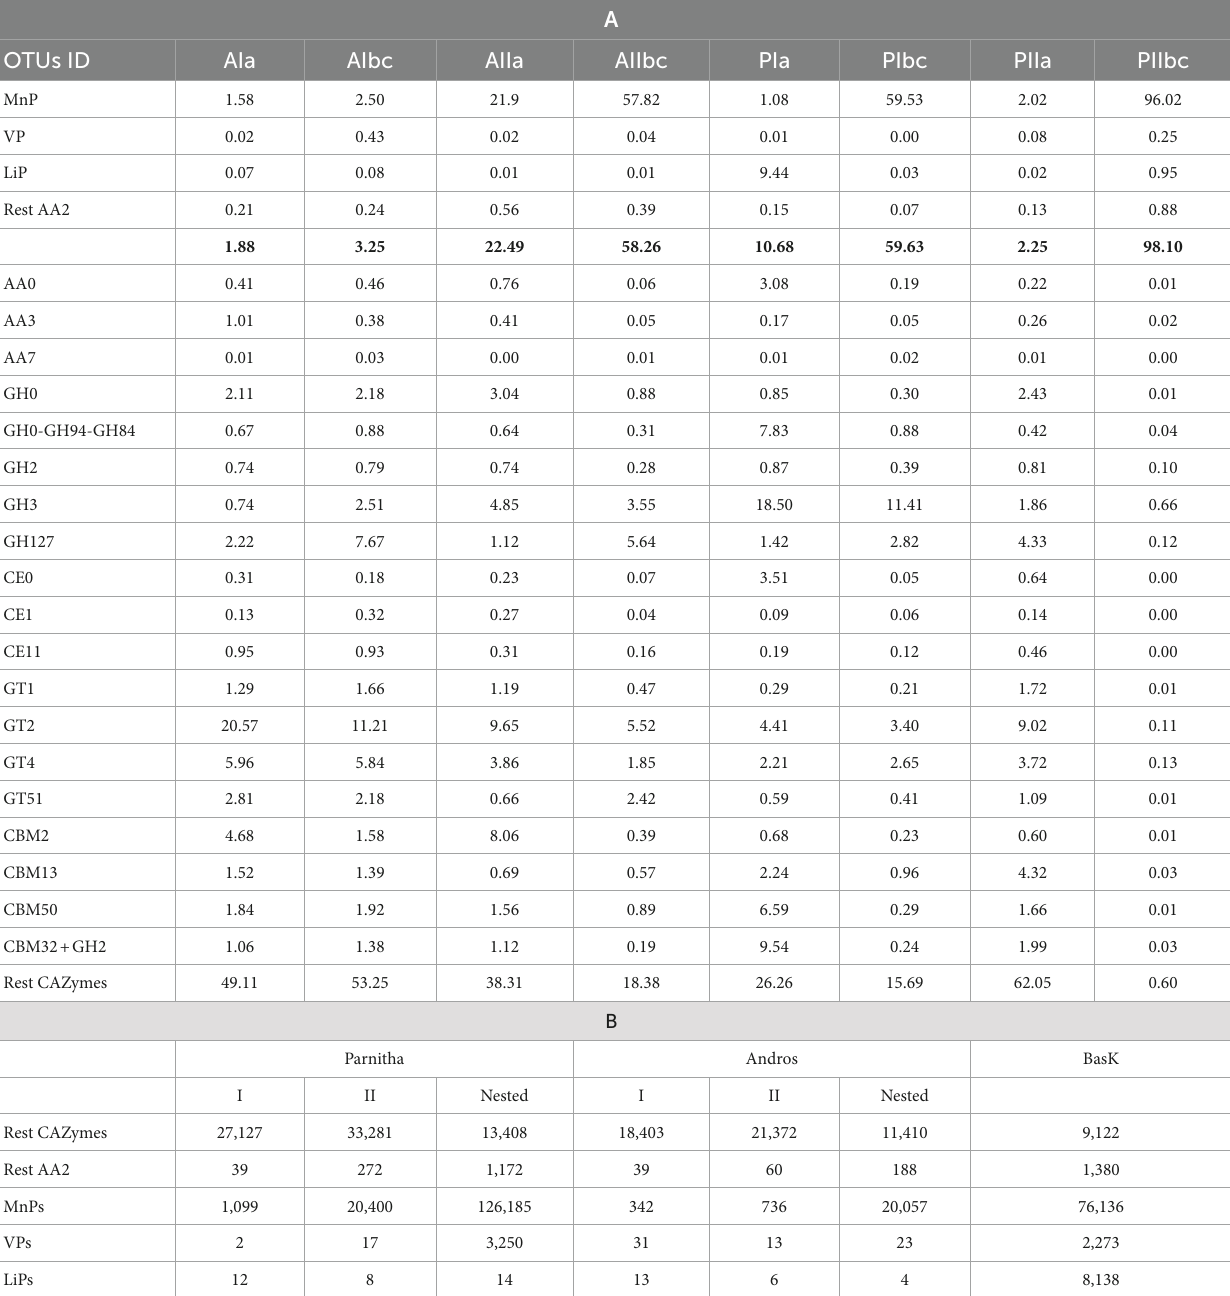
TABLE 1 (A) The distribution of the 44,119 CAZymes OTUs (%) in different enzyme groups, per forest (A = Andros, P = Parnitha), season (AI, PI = winter; AII, PII = summer) and soil layers (a = surface, b,c = 5–10 cm), and (B) distribution of CAZymes reads and AA2 enzymes in the two forests during winter (I) and summer (II) periods, irrespectively of sampling plot. It is pointed out that results from nested PCR were obtained only from half of the samples (see Supplementary Table S6). The relevant sequences obtained from the DNA pool of 10 species of basidiomycetes with known genomes (BasK) is also shown for comparison